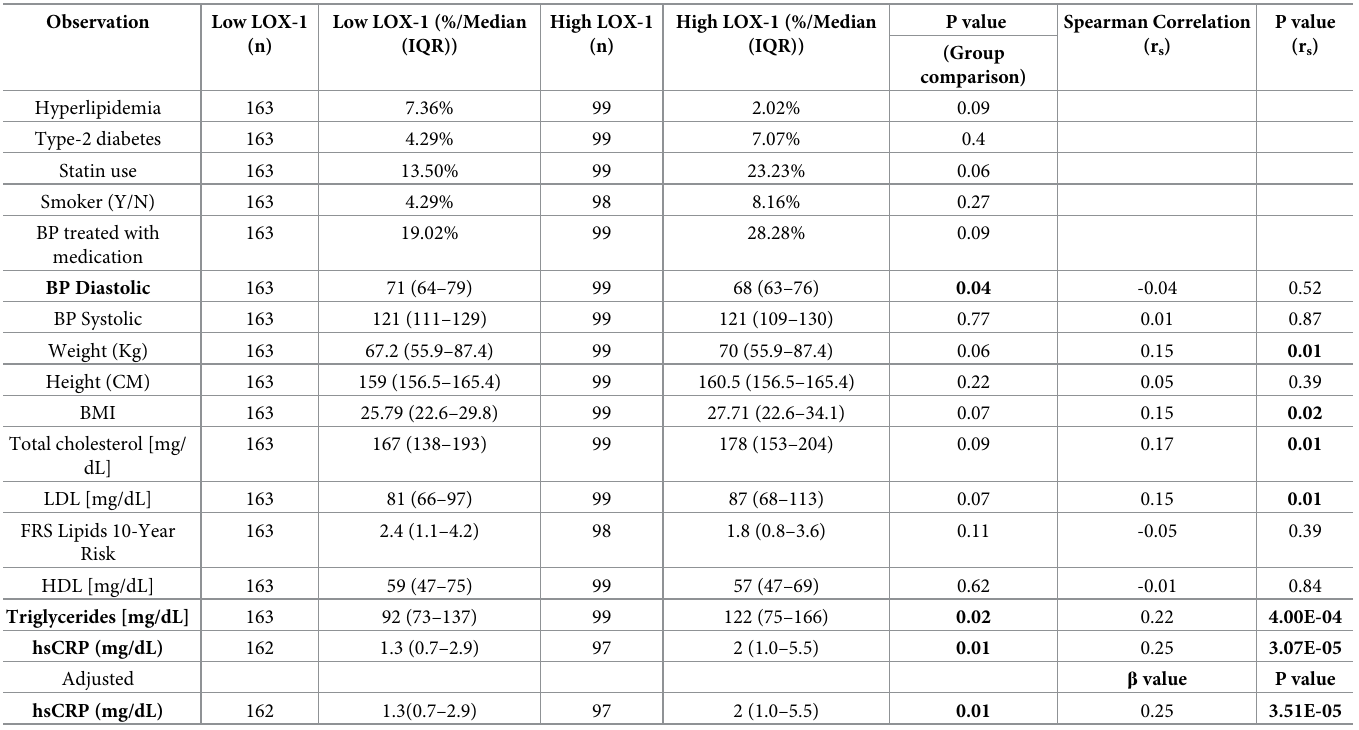
Table 2. Association between sLOX-1 and cardiovascular risk factors.